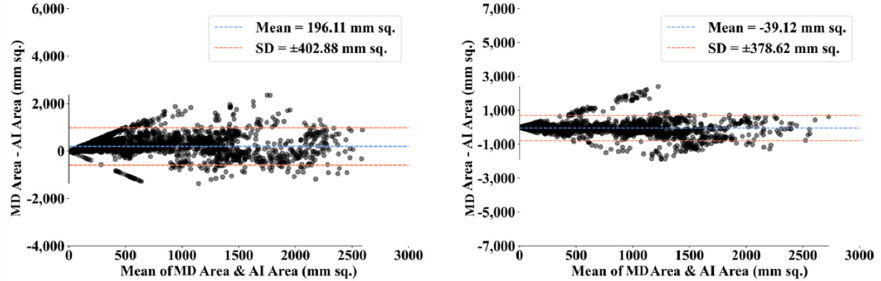
Figure 28. BA plot for ResNet ‐ SegNet using MD 1 (left) vs. MD 2 (right).